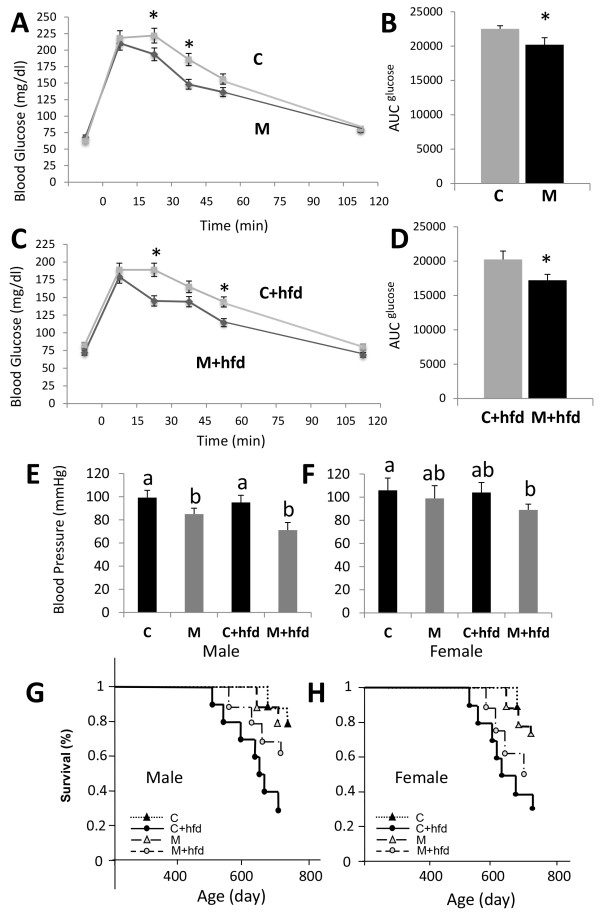
Microsomic animals recover faster from a glucose challenge and show a lower systolic blood pressure (SBP) than control animals. Glucose tolerance test performed in M and C male mice fed with a normal (A) or a high-fat diet (hfd) for 18 weeks (C). Area under the curve (AUC) for the glucose tolerance test performed in M and C mice fed with normal (B) or high-fat diet (hfd) for 18 weeks (D) (*P < 0.05. Error bars, s.e.m.). SBP recorded in M and C males (E) and females (F) fed with a normal or hfd for 18 weeks, respectively. [a, b] indicate a significant difference at P < 0.05. Error bars, s.e.m. Survival rate in M and C male (G) and female (H) fed with or without hfd, respectively.